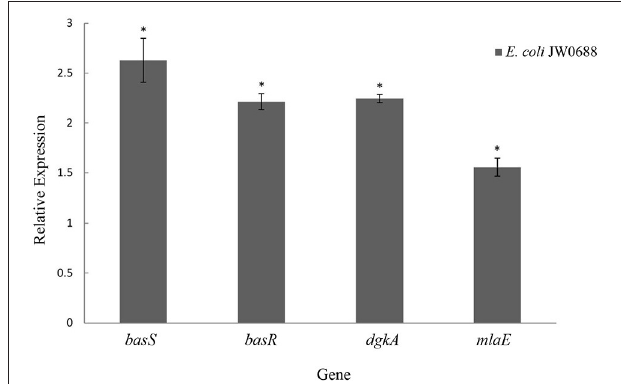
FIGURE 6 | Expression levels of BasS/BasR two-component system and its downstream regulatory genes in E. coli JW0688. *Means significant result.